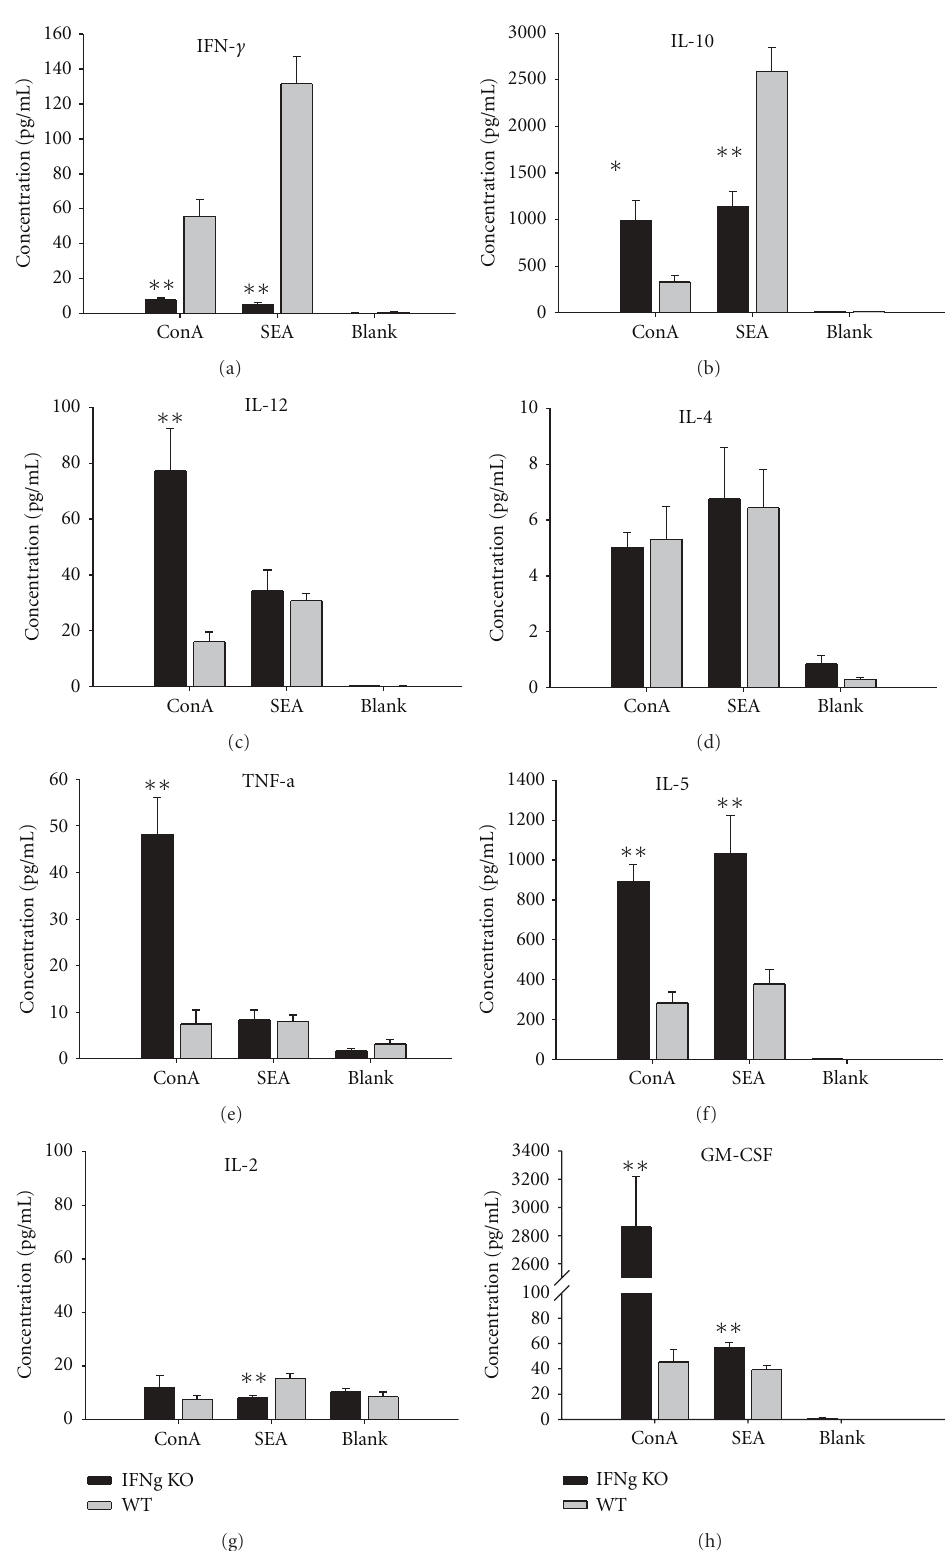
Figure 4: Type 1/Type 2 cytokine levels in the supernatant of splenocyte cultures of IFNg KO and WT mice ( n = 10, resp.) at 6 weeks after Schistosoma japonicum infection by Bio-Plex detection (compared with WT mice, ∗ P < 0 . 05, ∗∗ P < 0 . 01). Data are representative of two independent experiments with the similar